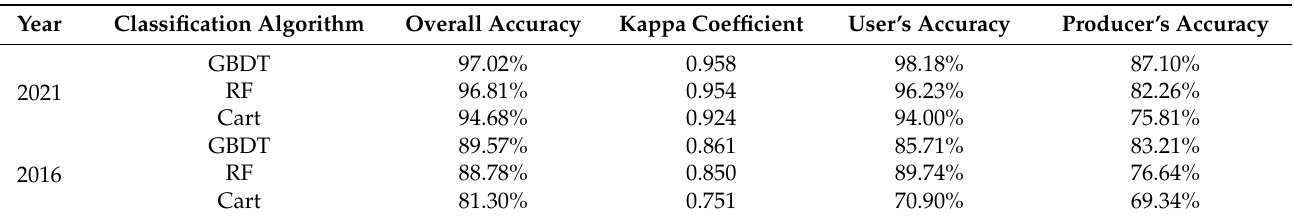
Table 4. Preliminary accuracy verification of the extraction results of lakes on the Tibetan Plateau by different classification